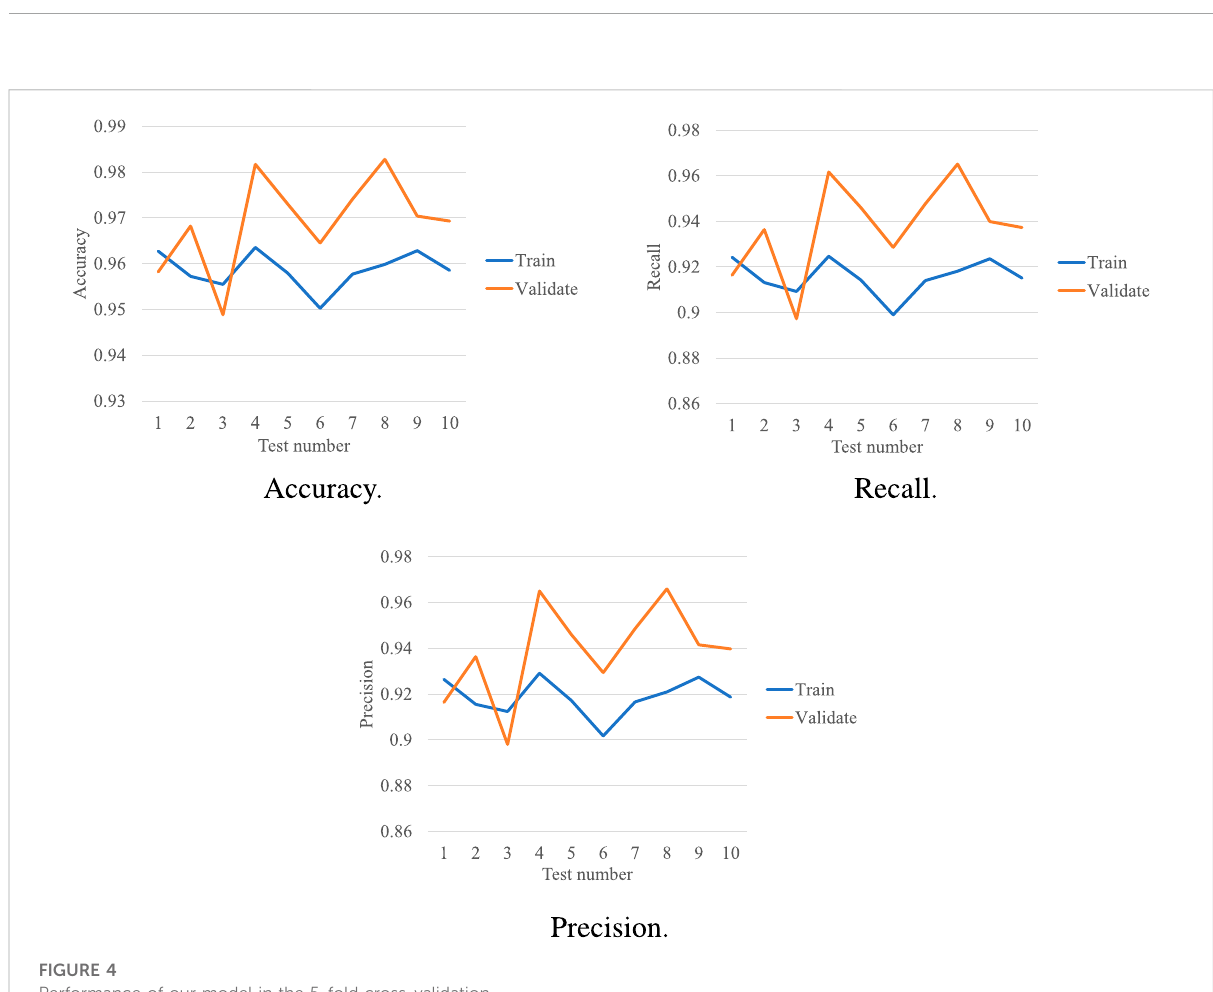
FIGURE 4 Performance of our model in the 5-fold